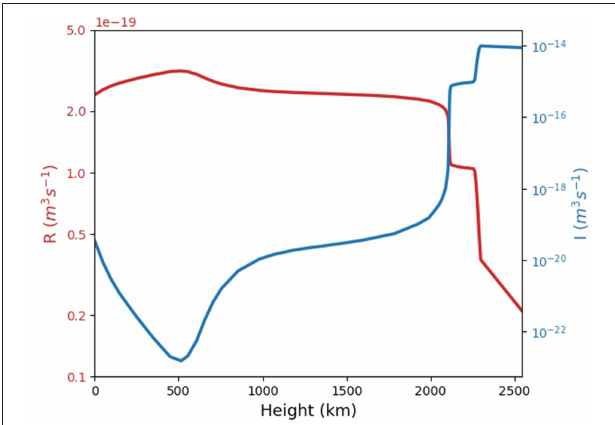
FIGURE 1 | The variation of the real and imaginary part of the dimensionless frequency for slow magnetoacoustic waves with respect to the dimensionless collisional frequency, a 1 , for two different values of the ionization degree of the plasma (color coded). Solid lines represent solutions obtained in the ionization non-equilibrium and dashed lines denote the slow waves in ionization